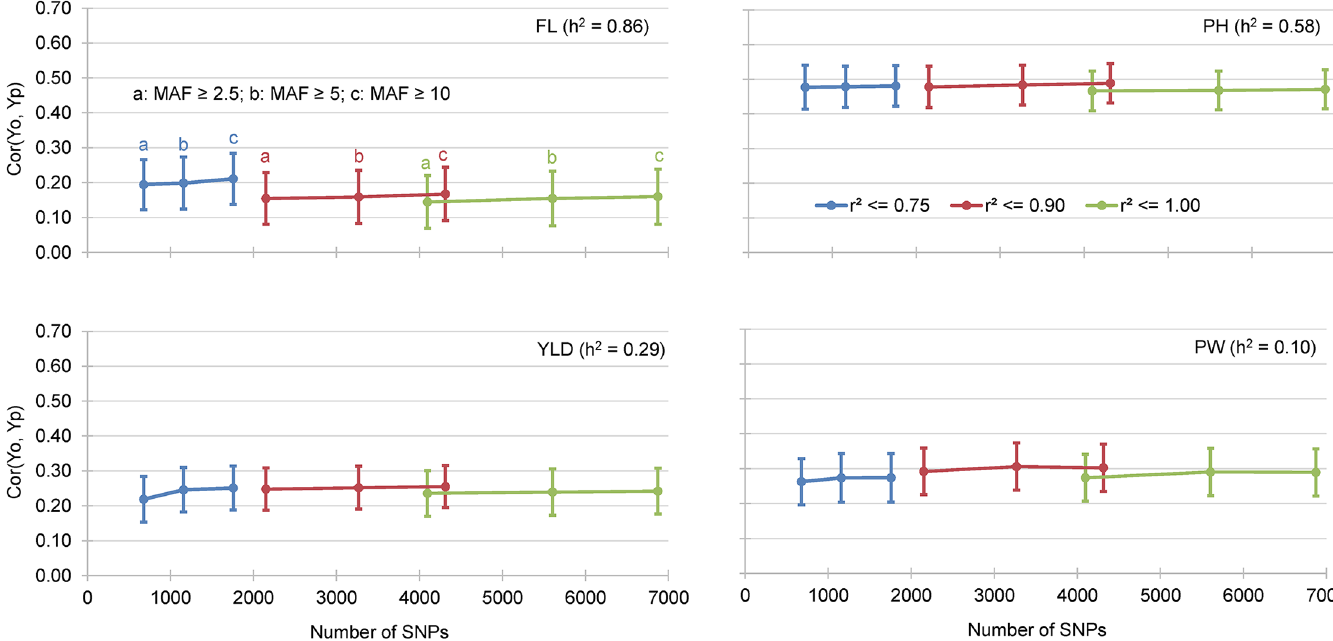
Fig 3. Mean correlation between GEBV obtained by cross validation of the training data set (Yp) and the observed BLUP values of the validation data sets (Yo). The results of 4 different traits and 9 incidence matrices are presented.